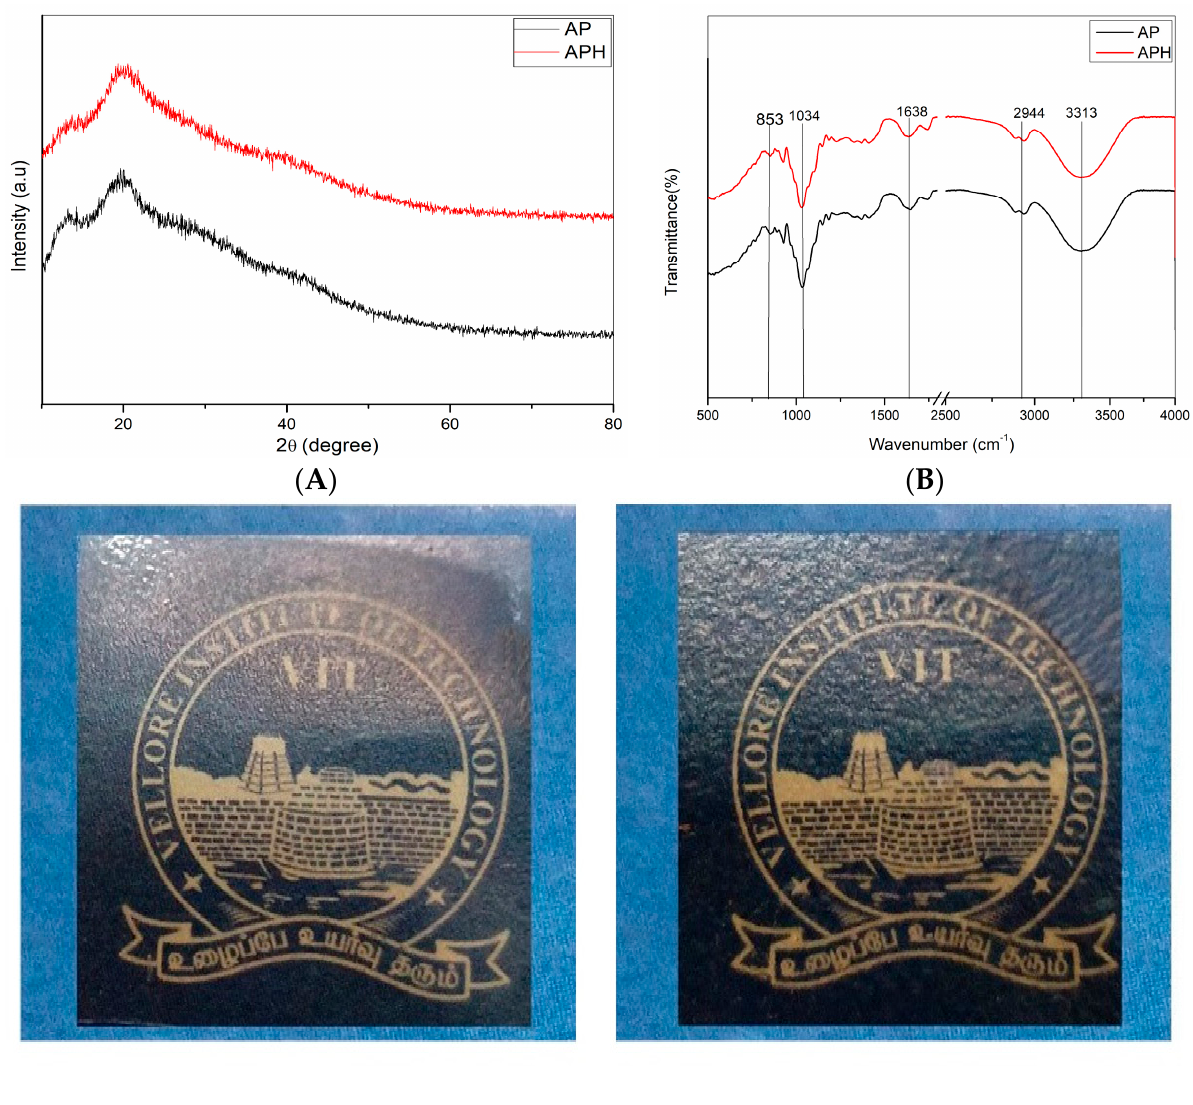
Figure 2. (A) XRD image. ( B ) FTIR spectrum. ( C ) Film transparency of AP and APH films. Figure 2. ( A ) XRD image. ( B ) FTIR spectrum. ( C ) Film transparency of AP and APH